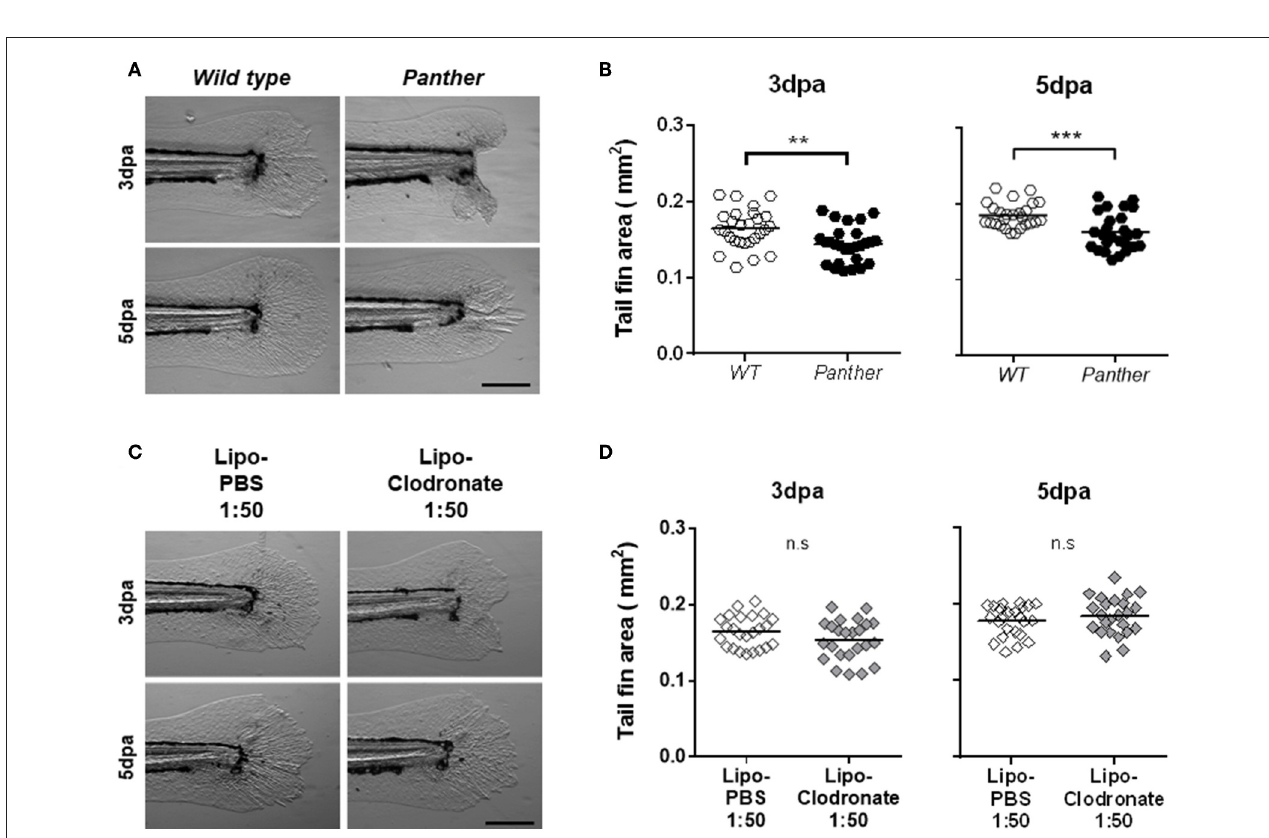
FIGURE 4 | Panther individuals exhibit an impaired tail fin regeneration. The tail fin area of regenerating tail fins was calculated at 3 and 5 dpa. (A) Representative regenerating tail fins in panther and WT larvae. Scale bar = 200 µ m. (B) Tail fin area quantification of regenerating tail fins in panther and WT larvae at both timepoints. A total of 27 larvae per group was used for the analysis. (C) Regenerating tail fin images of Lipo-clodronate 1:50 and Lipo-PBS 1:50 treated larvae. (D) Quantification of the tail fin area in Lipo-clodronate 1:50 and Lipo-PBS 1:50 treated individuals. A total of 24 larvae per group was used for the analysis. n.s not significant; ** p < 0.01; *** p <